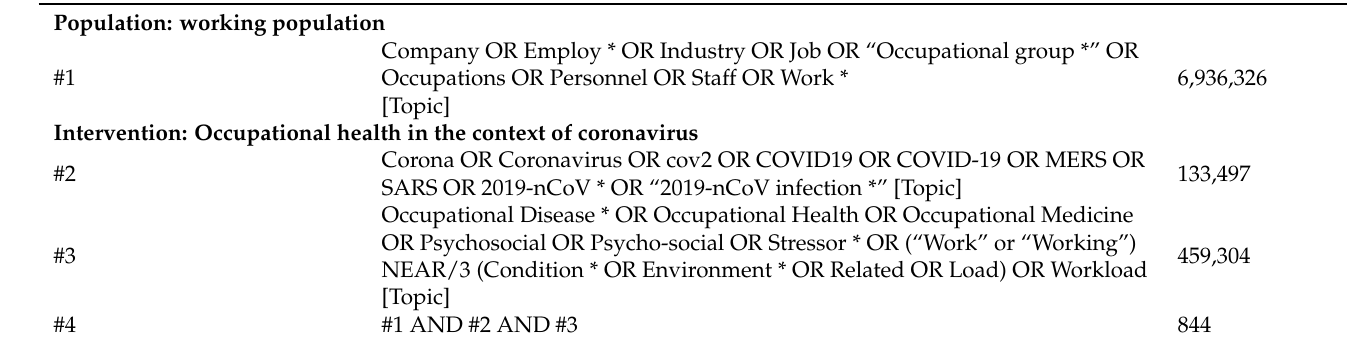
Table A4. Database: Web of Science Date: